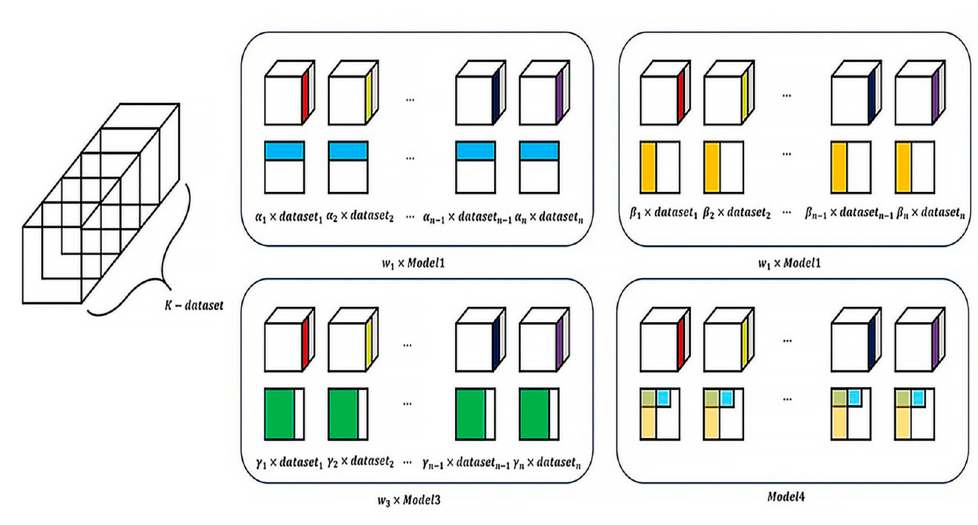
Figure 4. Cross-validation segmentation algorithm for solving data balancing problems.